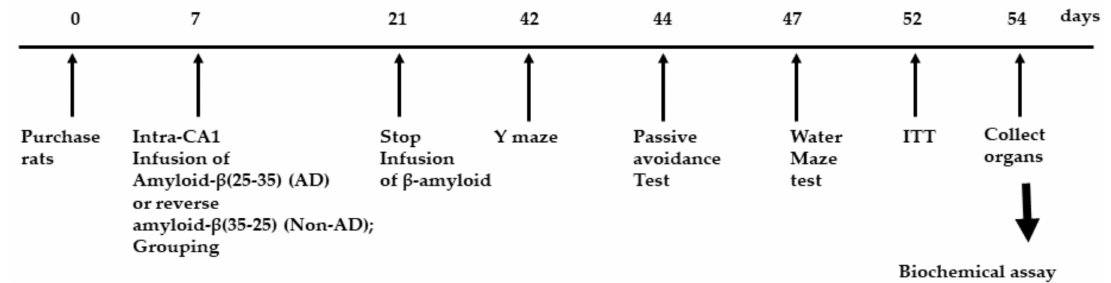
Figure 2. Experimental design. Groups included were 1) AD-Con fed 45% fat diet with 0.5% dextrin in Alzheimer’s disease (AD) rats having the intra-CA1 infusion of amyloid- β (25–35), 2) AD-TTK fed 45% fat diet with 0.5% water extract of Tetragonia tetragonioides (TTK) in AD rats, and 3) Normal-Con fed 45% fat diet with 0.5% dextrin in non-AD rats having the intra-CA1 infusion of amyloid- β (35–25). Table 1. Body weight and glucose metabolism at the end of experimental periods. Metabolic Parameters AD-Con AD-TTK Normal-Con Body weight (g) 398 ±